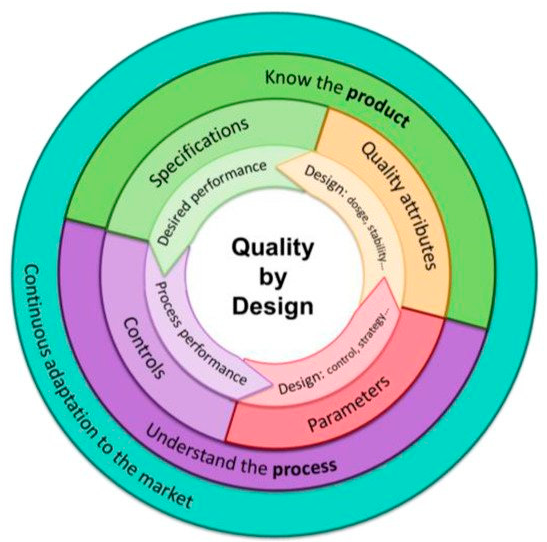
Figure 1. QbD lifecycle. Reprinted with permission from Fornaguera. et al. Journal of Personalized Medicine , 7(4). Copyright (2017) MDPI [40].